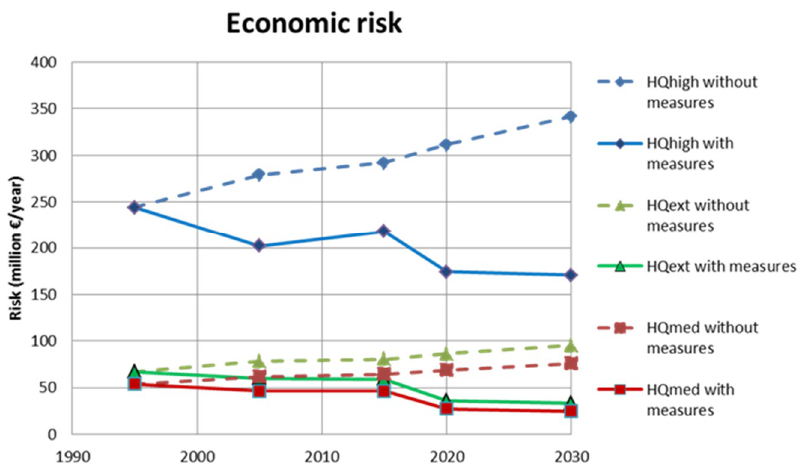
Figure 12. Development/Evolution of economic risk from 1995 to 2030 (€ million/a) [8].